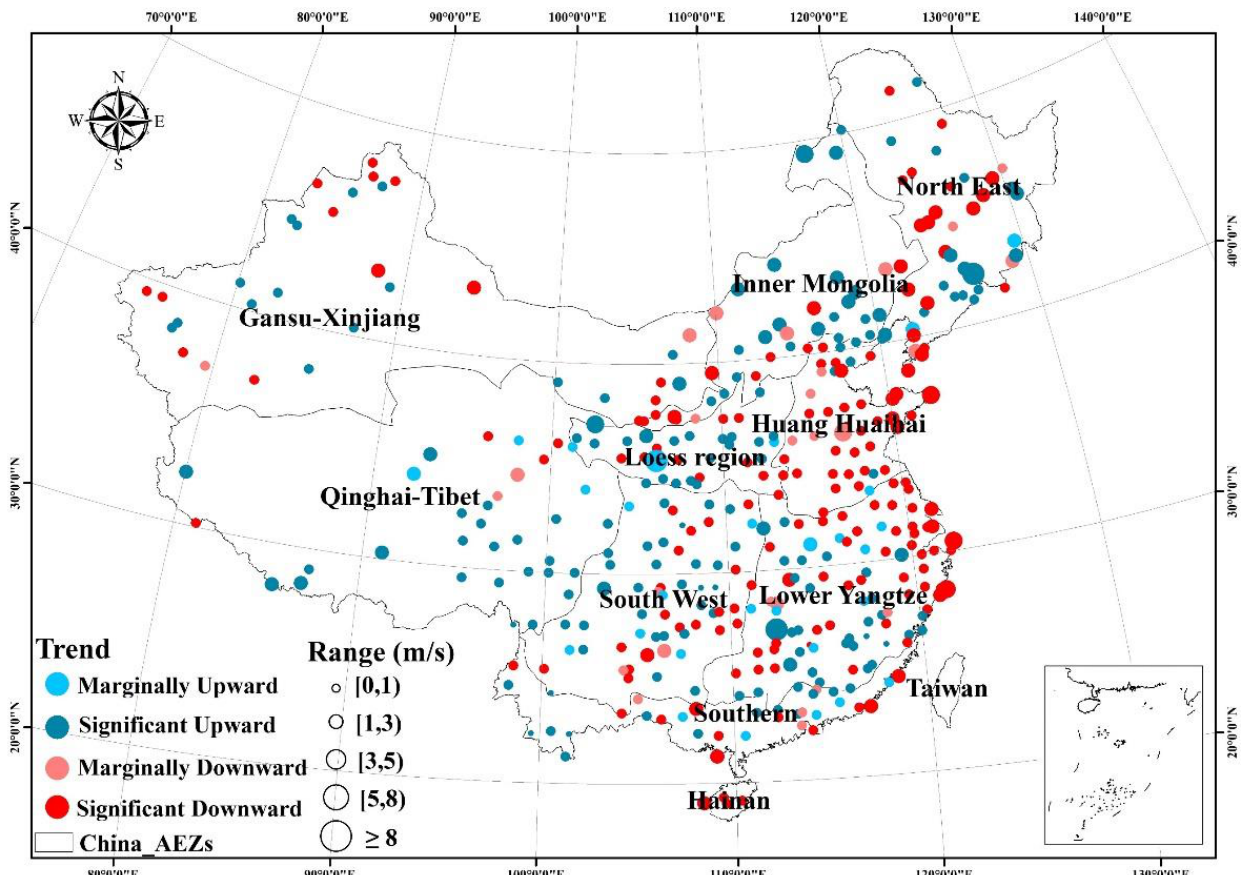
Figure 12. The spatial distribution of different wind speed ranges from 2000 to 2019 over the different agricultural ecology zones of China.